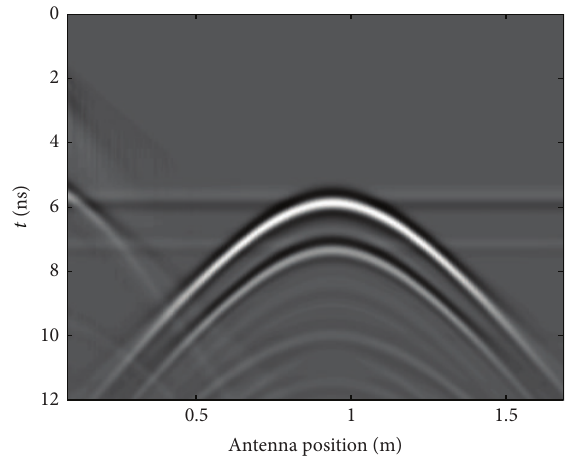
Figure 6: A-Scan trace of